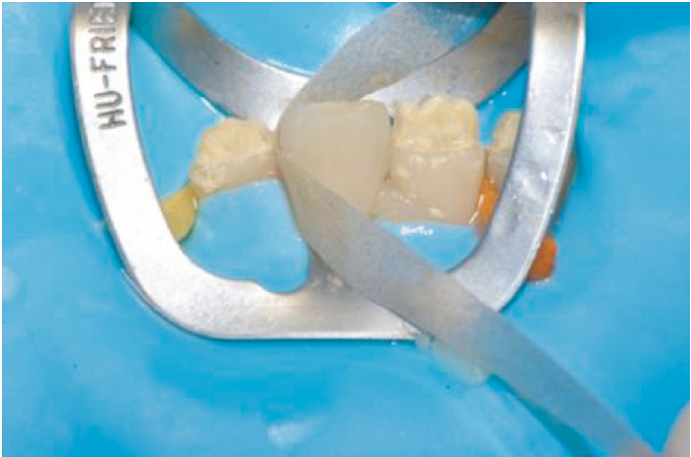
Figure 15: Interproximal fi nishing with composite paper fi nishing strip.